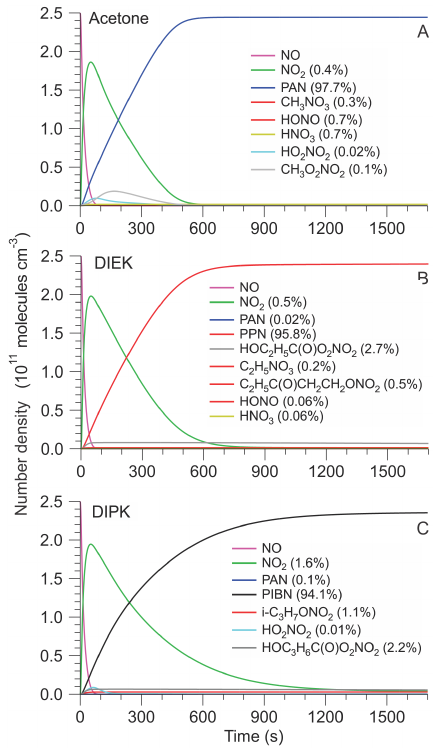
Figure 6. MCM box model simulations with different dialkyl ke- tones as starting material: (a) Acetone. (b) Diethyl ketone (DIEK). (c) Diisopropyl ketone